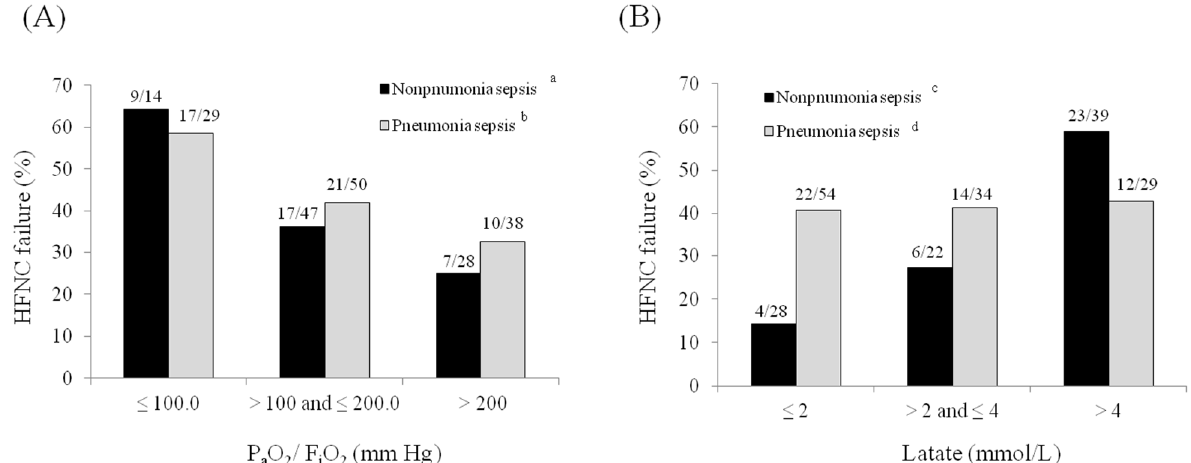
Figure 4. Rates of early high-flow nasal cannula failure according to ( A ) the P a O 2 /F i O 2 ratio and ( B ) lactate level. a p = 0.045, b p = 0.028, c p = 0.001, and d p = 0.988.